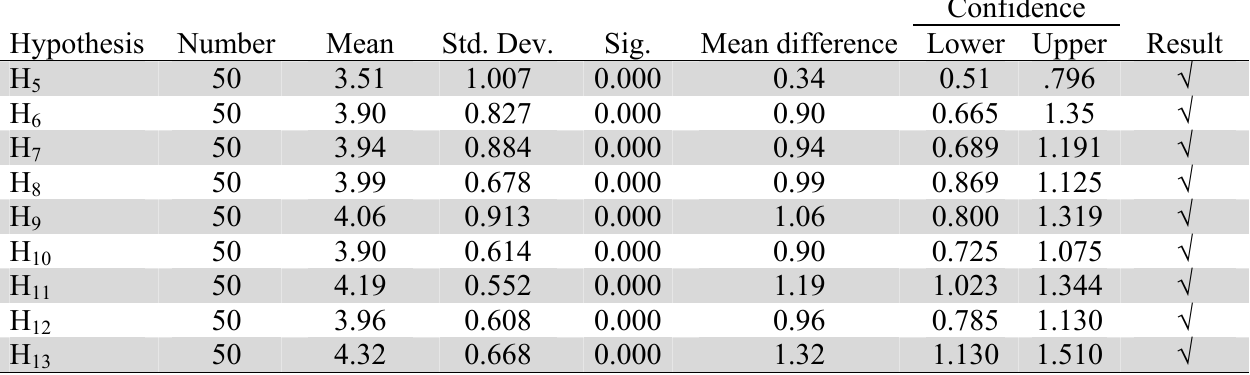
The summary of some basic statistics and testing management characteristics